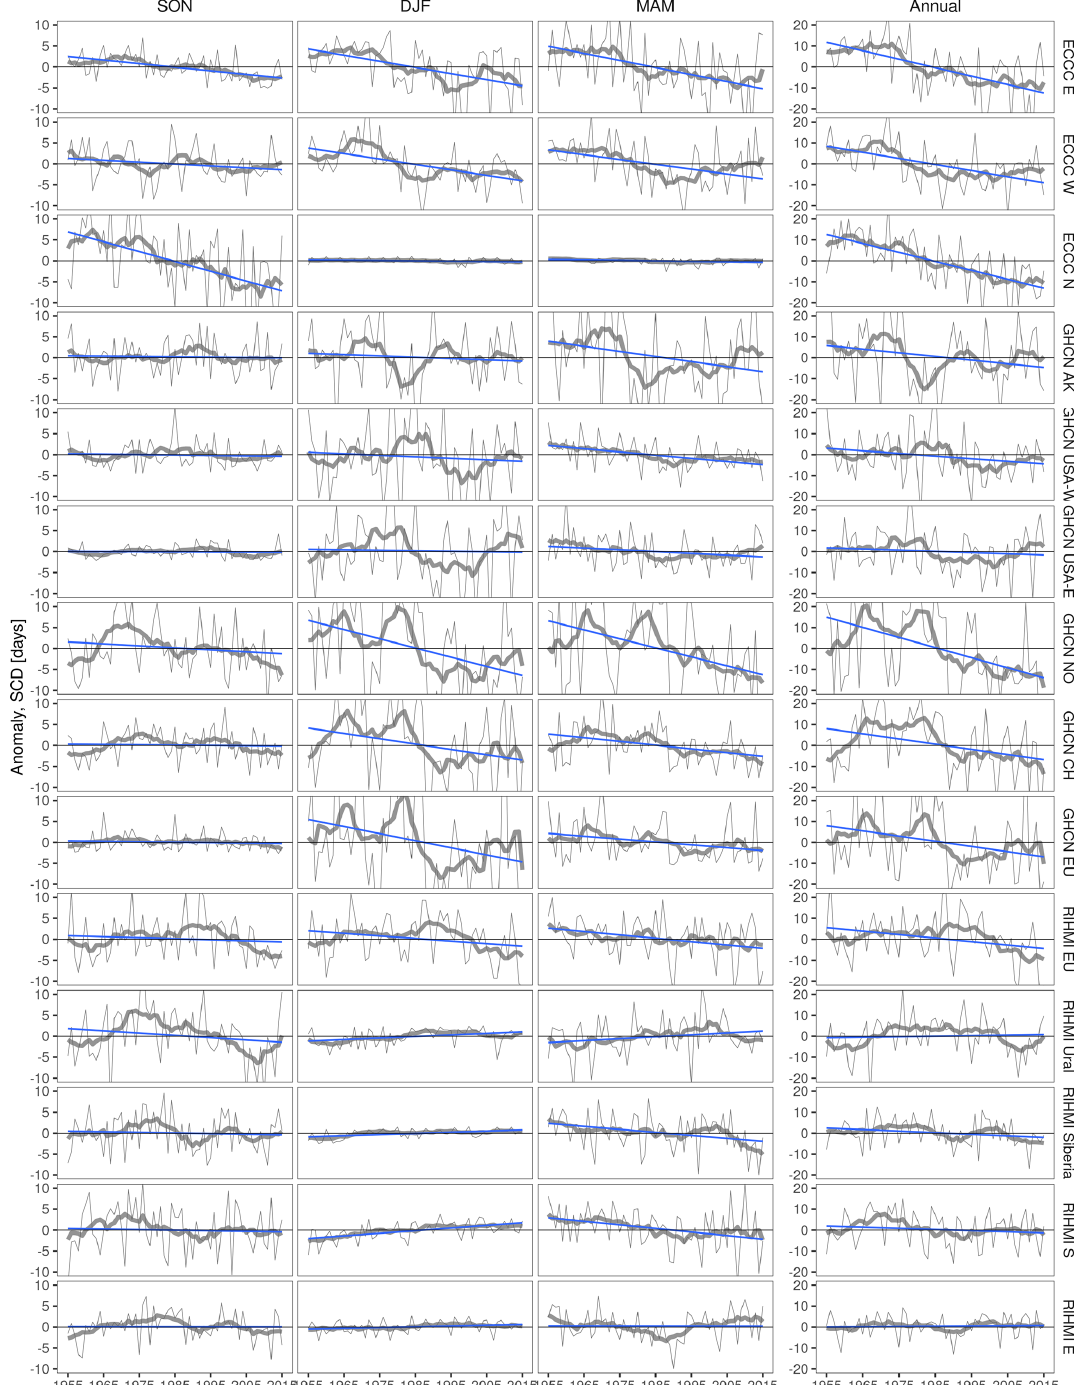
Figure A10. Annual and seasonal anomalies in snow cover duration (SCD) per spatial region compared to the 1955–2015 reference period. Thick gray lines show the 10-year running